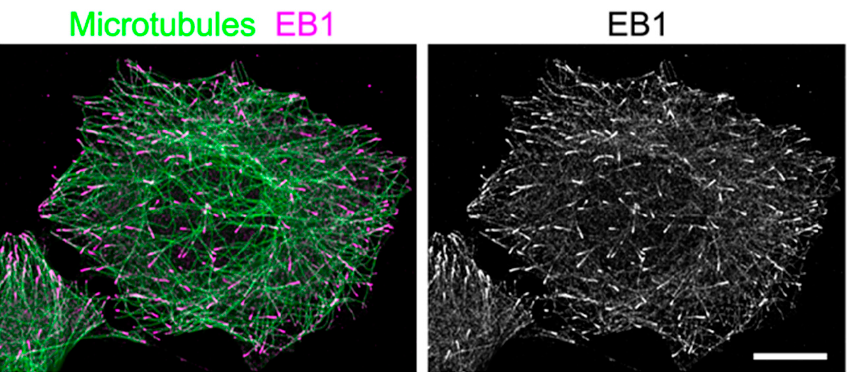
Figure 1. Distribution of end-binding 1 protein (EB1) in a flat, interphase HeLa cell. HeLa cells were fixed and immunostained for microtubules (green) and EB1 (magenta), and visualized by conventional confocal microscopy (LSM780, Carl Zeiss) to show EB1 localization at microtubule ends. In the right image, only EB1 signals are shown in grayscale. Scale bar: 5 μ m.